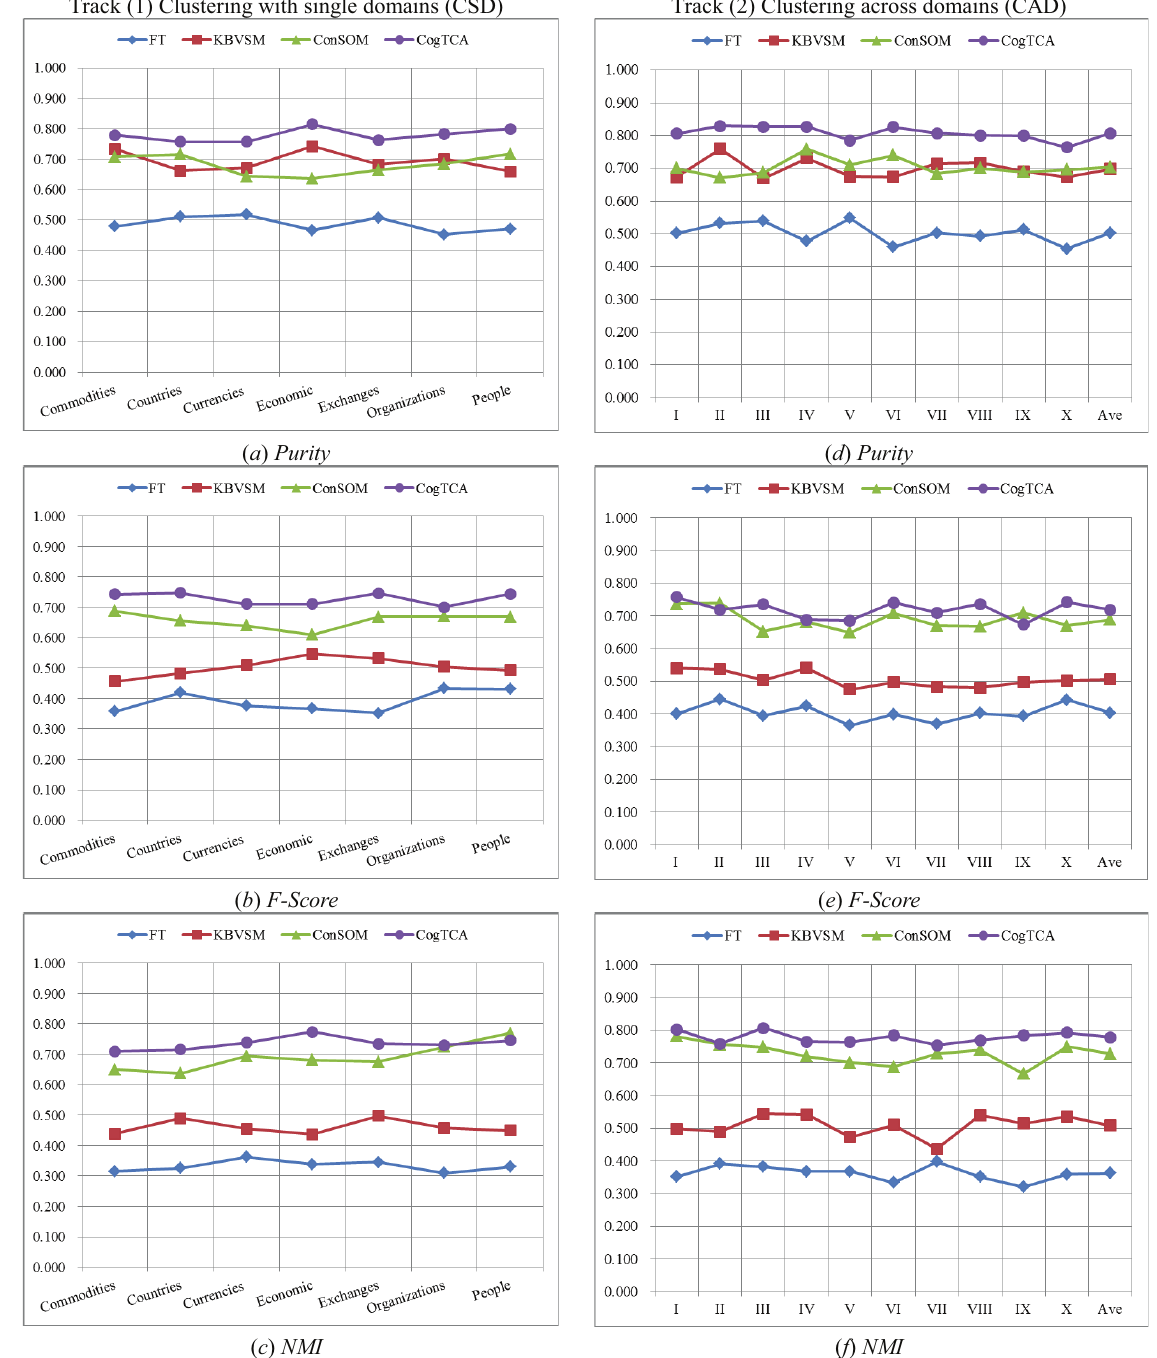
Fig.4. Experimental results of CSD and